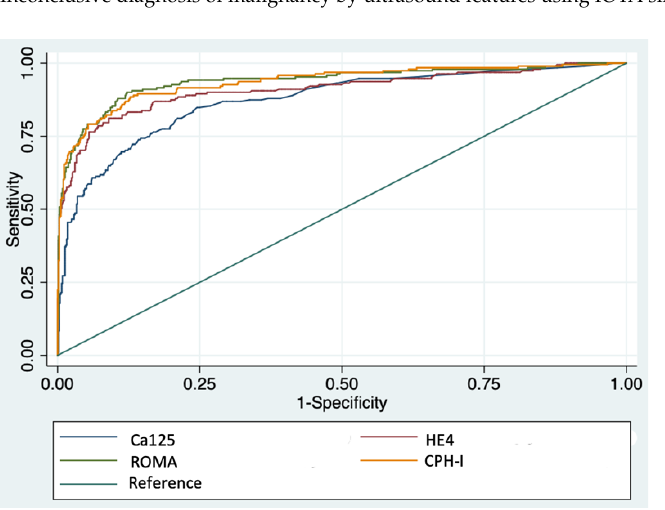
CPH-I at different cutoff points previously reported by literature. None of the tumor markers alone achieved a sensitivity of 90%; HE4 at a cutoff point of 70 for